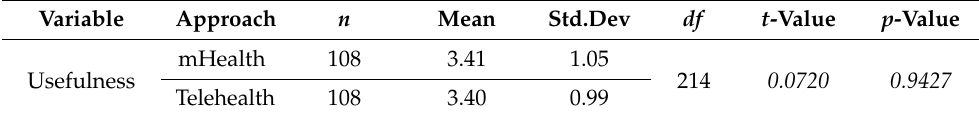
Table 9. Difference in interaction quality of mHealth and Telehealth.